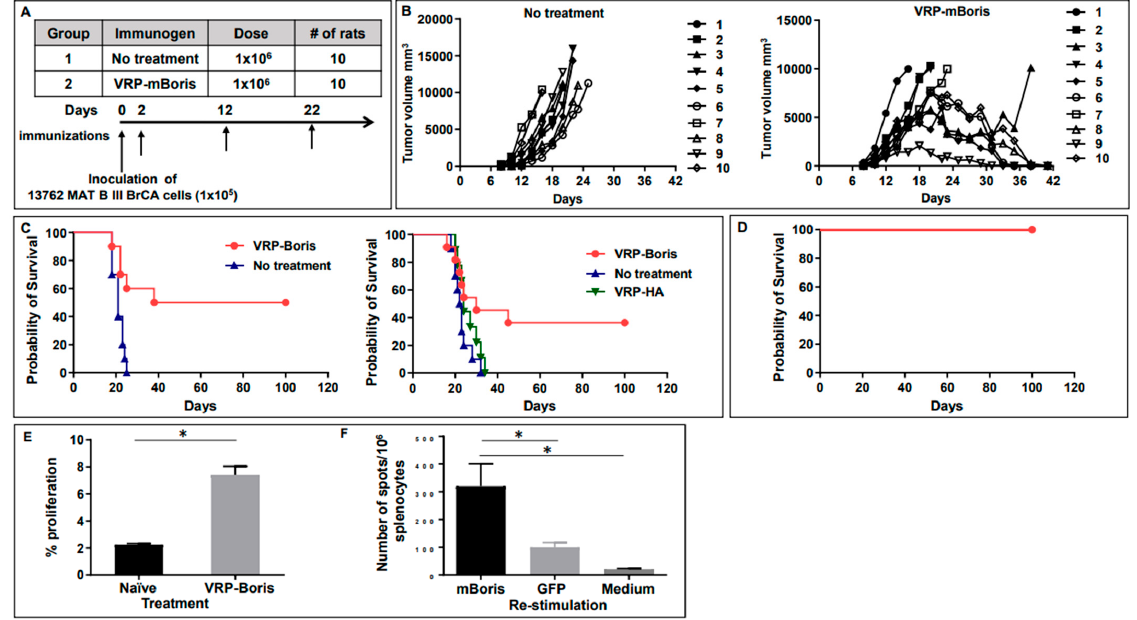
Figure 4. Therapeutic vaccination with VRP-mBORIS inhibits tumor growth and cures rat breast cancer, inducing antigen-specific cellular responses. ( A ) The experimental design of the therapeutic study. Rats were treated with VRP-mBORIS 2 days after injection of the 1 × 10 5 13762 MAT B III BrCA cells. ( B ) Depicts the tumor size of individual animals on the designated days for VRP-mBORIS treatment and non-treated animals. ( C ) Depicts survival of rats in two independent experiments. In one experiment, rats were also treated with irrelevant therapeutics VRP-HA. It was observed that 38–50% of rats were completely cured of the disease, while rats without treatment or treated with irrelevant immunogen died on days 25–34. ( D ) Survived mice were re-challenged by inoculation of the 1 × 10 5 13762 MAT B III BrCA cells. It was observed that 100% of rats were resistant and did not develop a new tumor. ( E ) Proliferation upon in vitro restimulation with recombinant mBORIS protein. Splenocytes labeled with CFSE were restimulated in vitro with 160 µg/mL recombinant rat Boris or recombinant GFP in the presence of 50 U/mL IL-2. Four days later, cells were collected and analyzed for proliferation by dilution of the CFSE signal using flow cytometry. Data are represented here as the % of cells that had undergone at least one round of proliferation in response to stimulation with recombinant mBORIS protein—the % of cells that had undergone at least one round of proliferation in response to stimulation with the control protein, recombinant GFP. Data depicted here were generated from cohorts of three animals. Error bars represent standard error, * indicates p < 0.05. ( F ) IFN γ producing splenocytes were detected after in vitro restimulation with indicated proteins by ELISPOT assay.